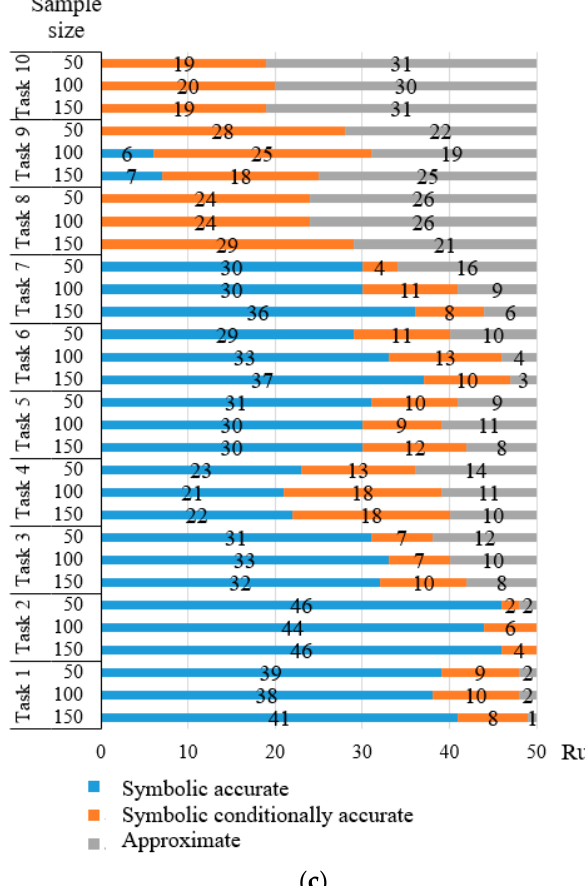
Figure 7. Symbolic accuracy of the resulting ODEs: ( a ) Data without noise; ( b ) Data with 5% of noise; ( c ) Data with 10% of noise.